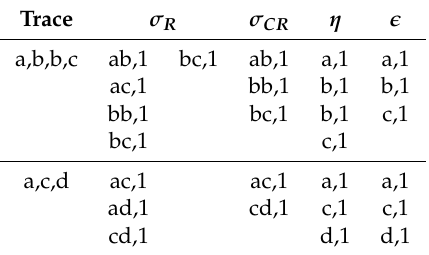
Table 2. Output Mapper MR-I [16].